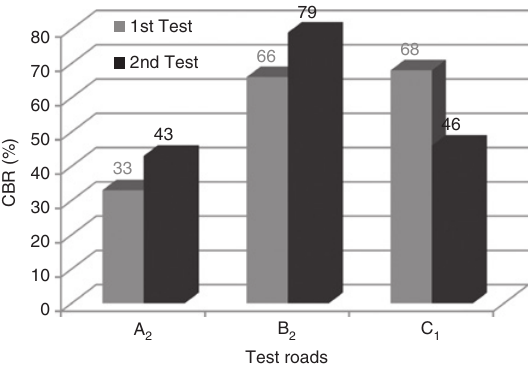
Figure 4: Variation of base layer’s CBR according to the DCP test